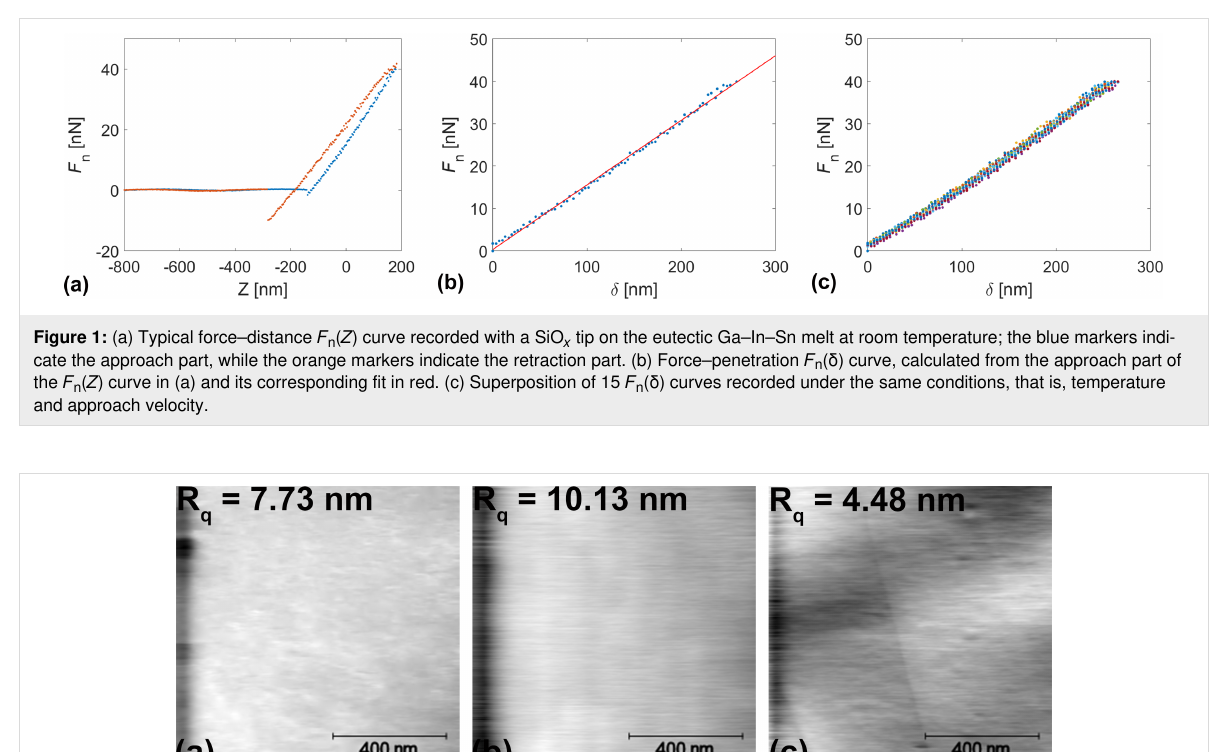
copy measurements at each approach/retraction velocity 15